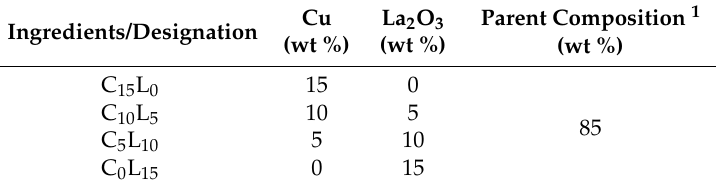
Table 5. Formulation design and designations of